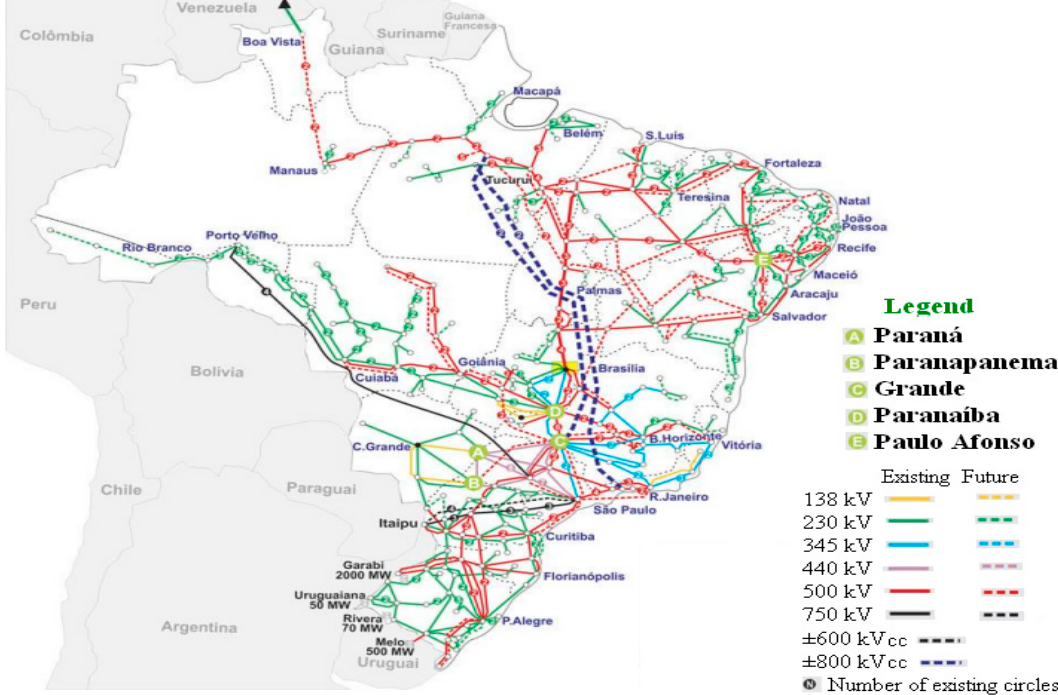
Figure 1. Smart grid of the Brazilian electrical system. Source: Schio [43].